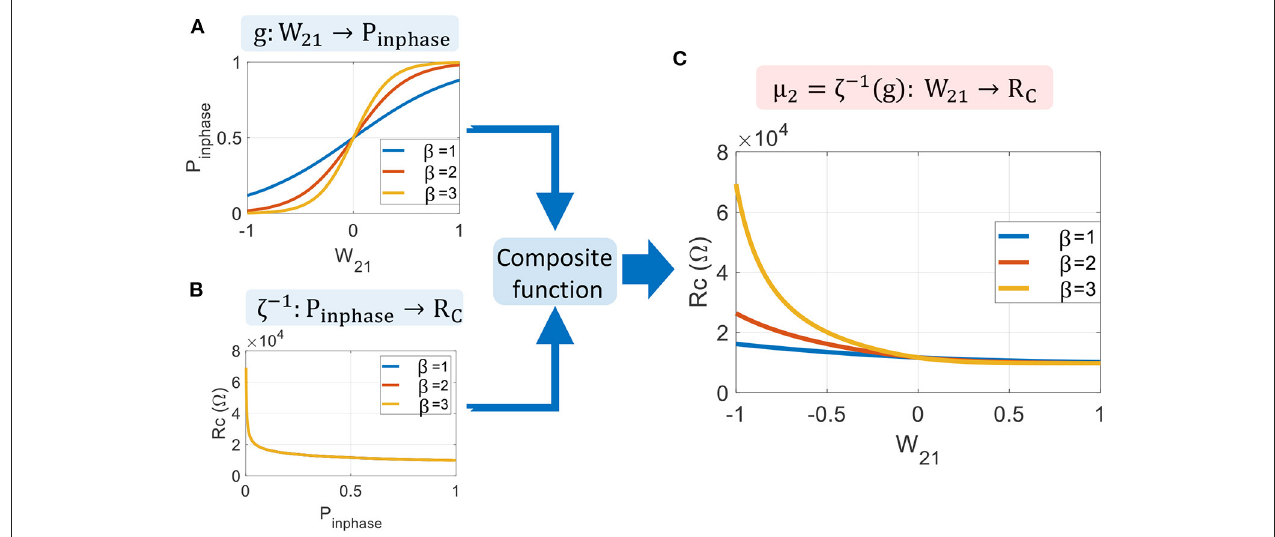
FIGURE 11 | Mapping function for two coupled oscillators. (A) Sigmoid activation function presents the probability P inphase for the two oscillators to be in phase. (B) Inverse of the transition function ζ − 1 determines the coupling resistance R C for a given probability P inphase . (C) The mapping function µ 2 is obtained by the composite function ζ − 1 ( g ).